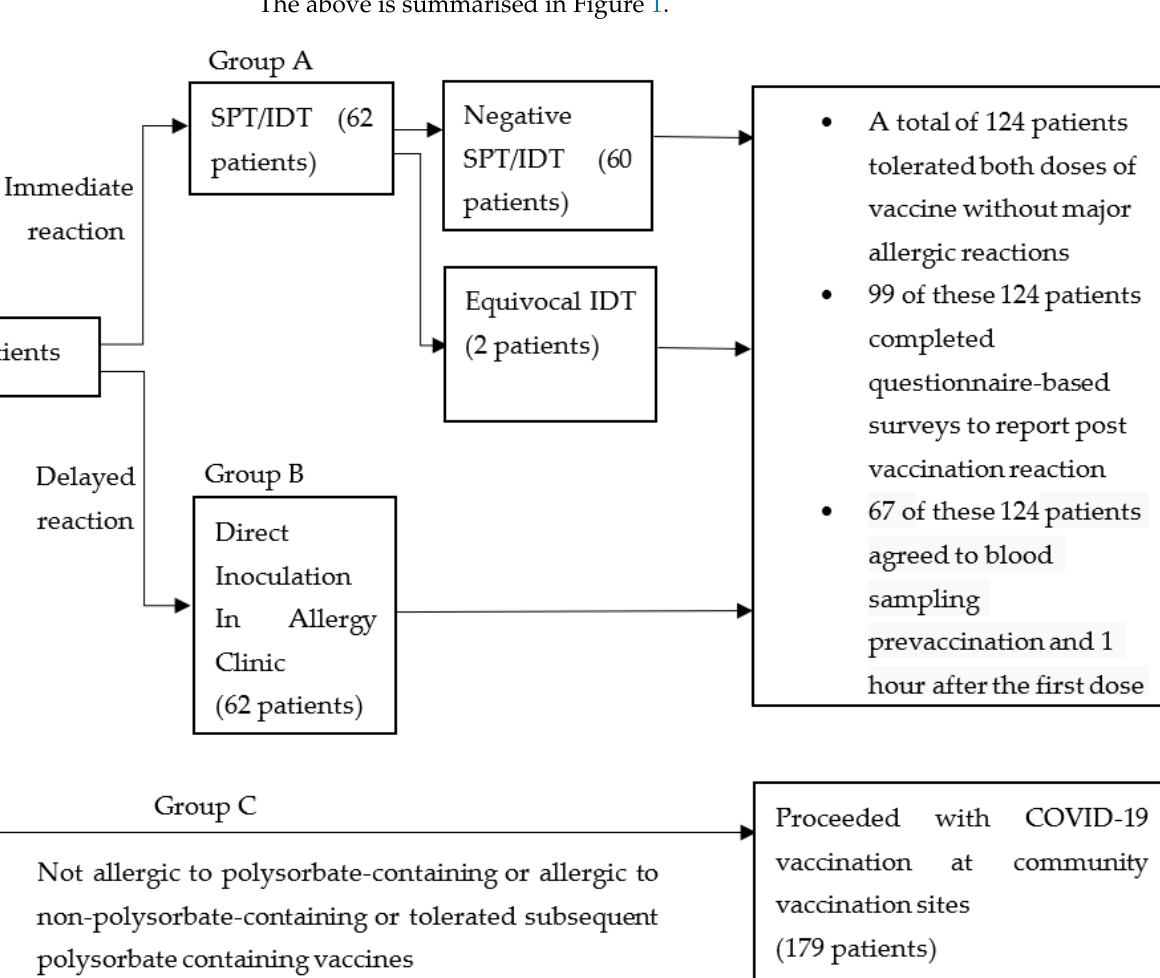
Figure 1. Grouping and evaluation strategy for patients referred for evaluation of non-COVID-19 vaccine allergies prior to mRNA COVID-19 vaccination. vaccine allergies prior to mRNA COVID-19